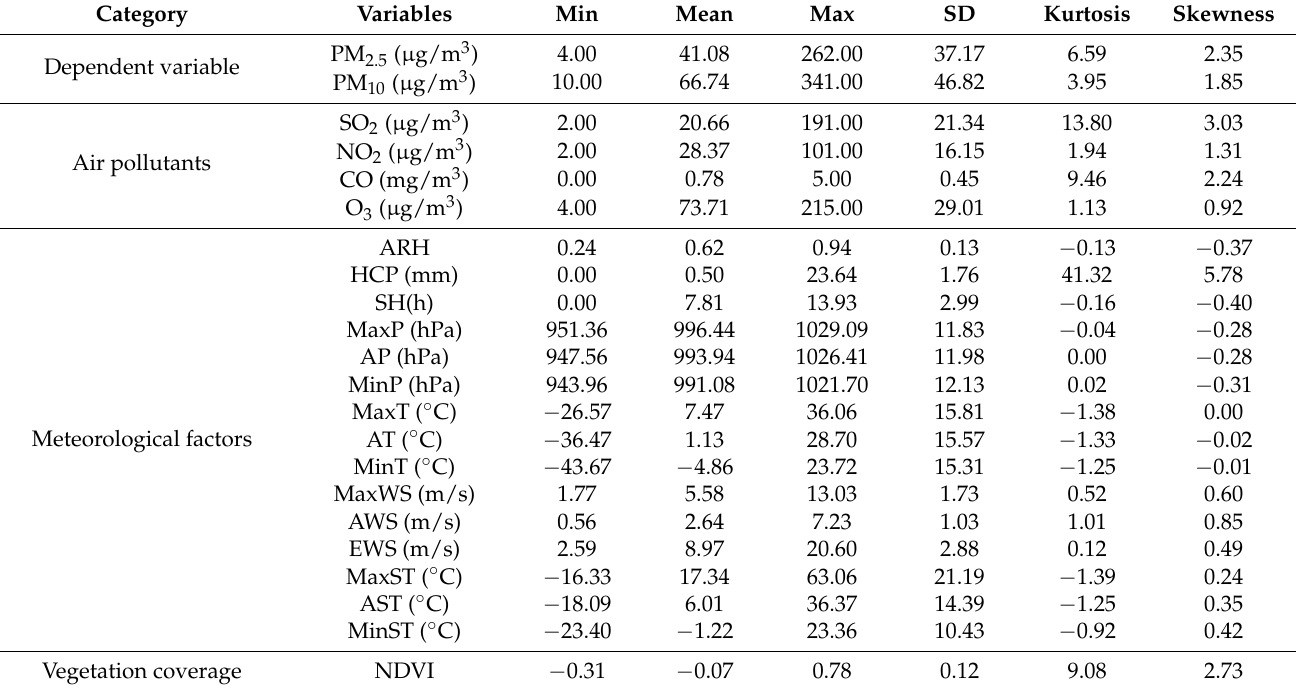
Table 1. Descriptive statistics of the variables used in this